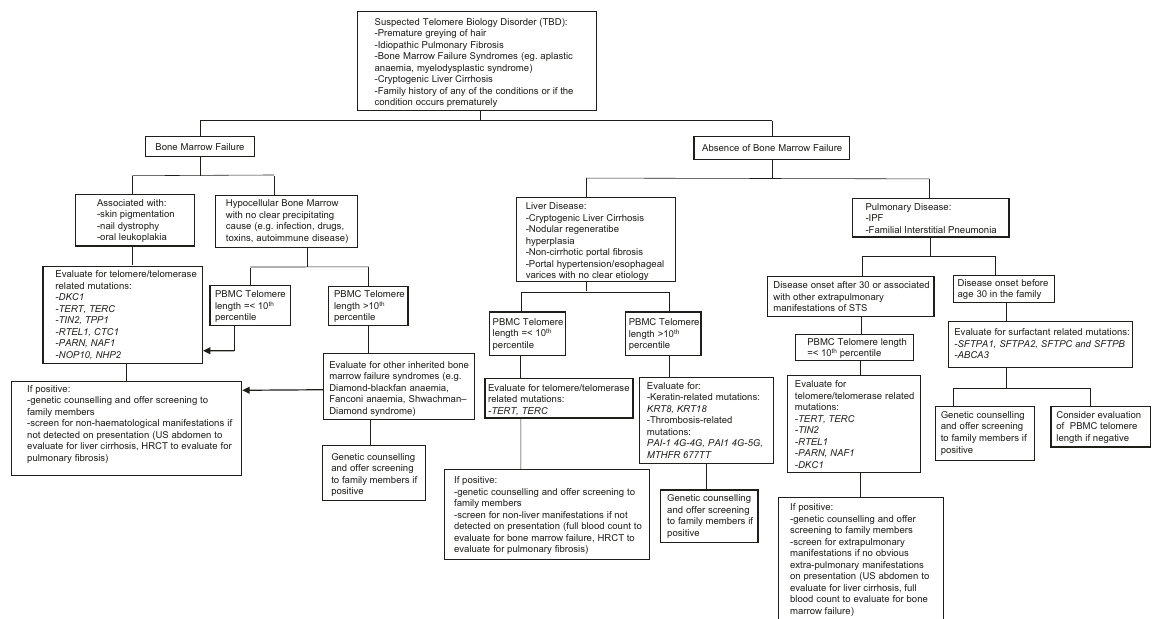
Fig. 6 Proposed pathway for evaluation of suspected telomere biology disorders. HRCT, high-resolution computed tomography scan; IPF, idiopathic pulmonary fi brosis; PBMC, peripheral blood mononuclear cell; US,